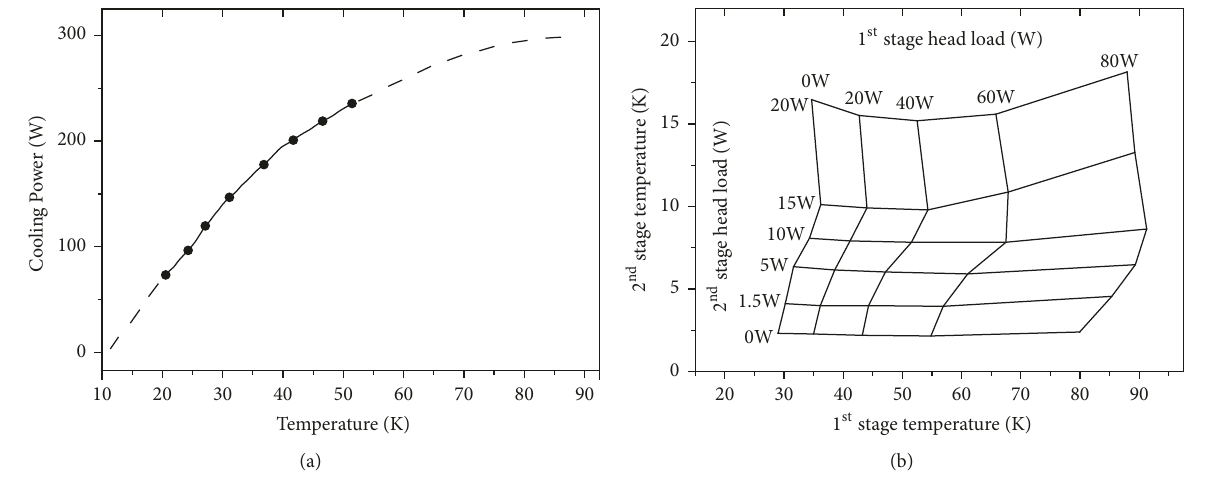
Figure 5: Cooling power along with temperature: (a) AL-325; (b) KDE-415.